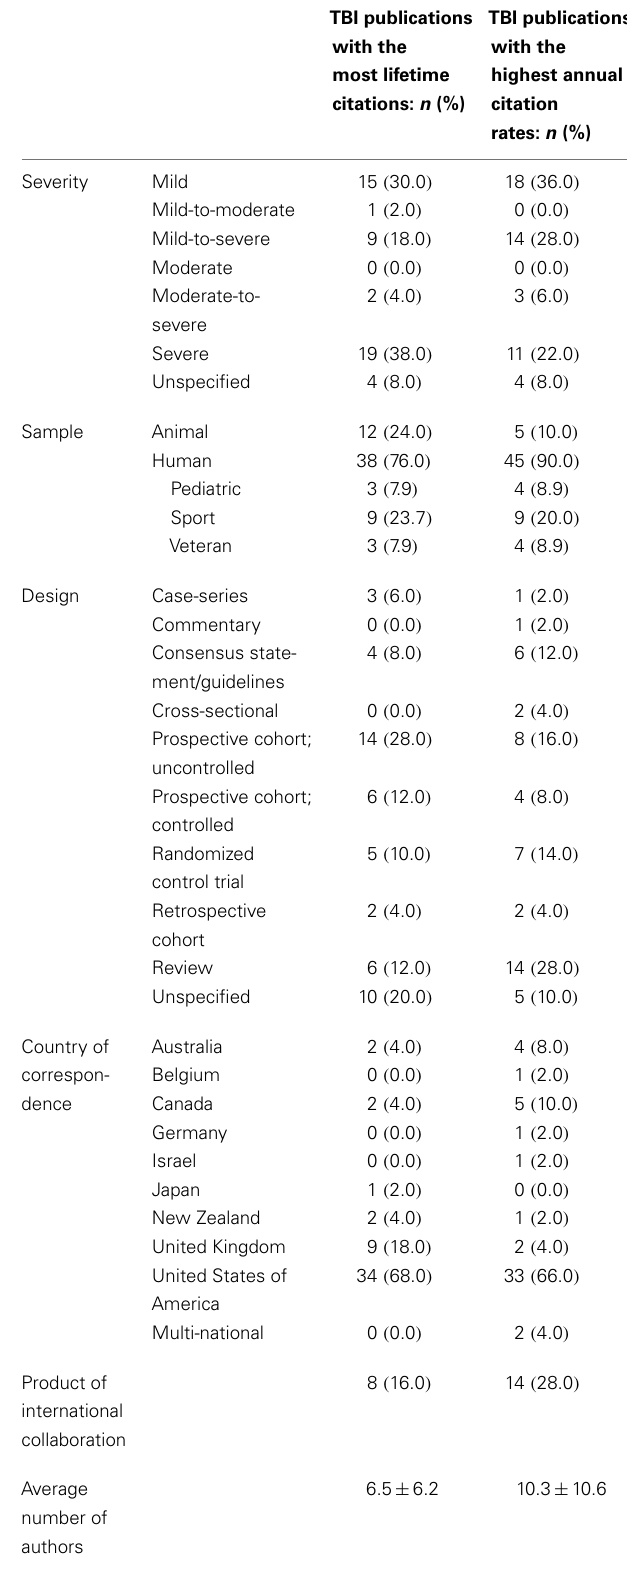
Table 3 | Characterization of the two citation cohorts